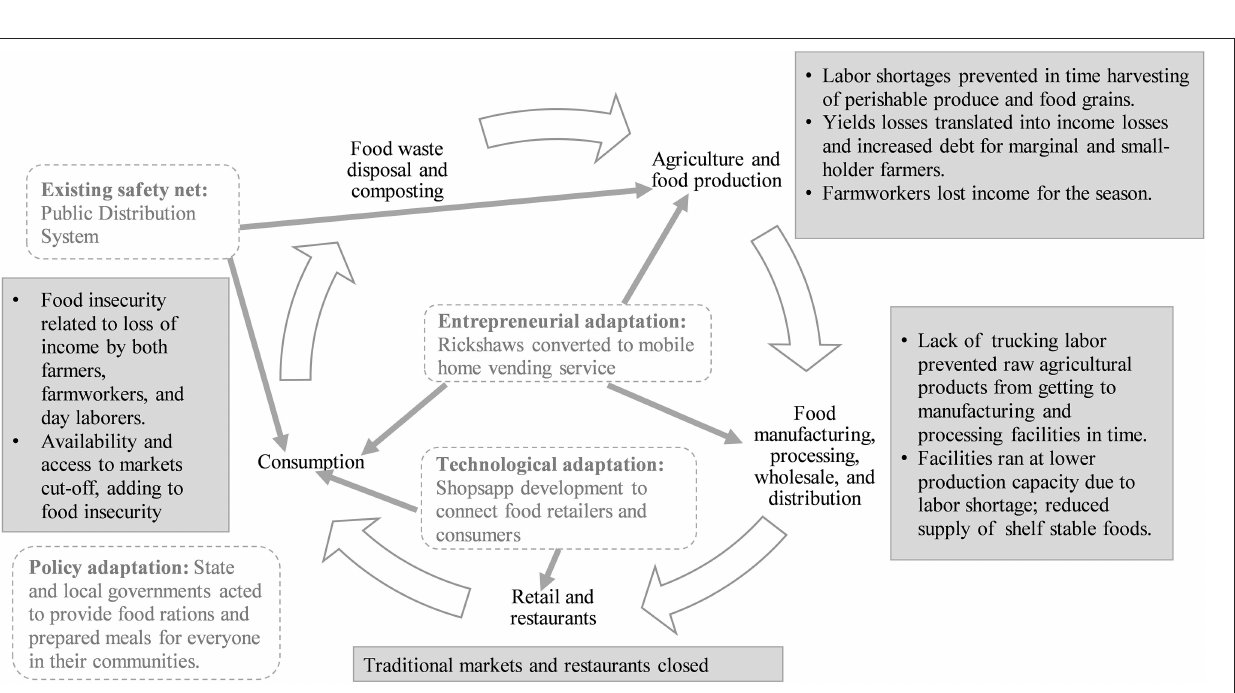
FIGURE 4 | COVID-19 impact on the food system and adaptations in Madera County, USA.